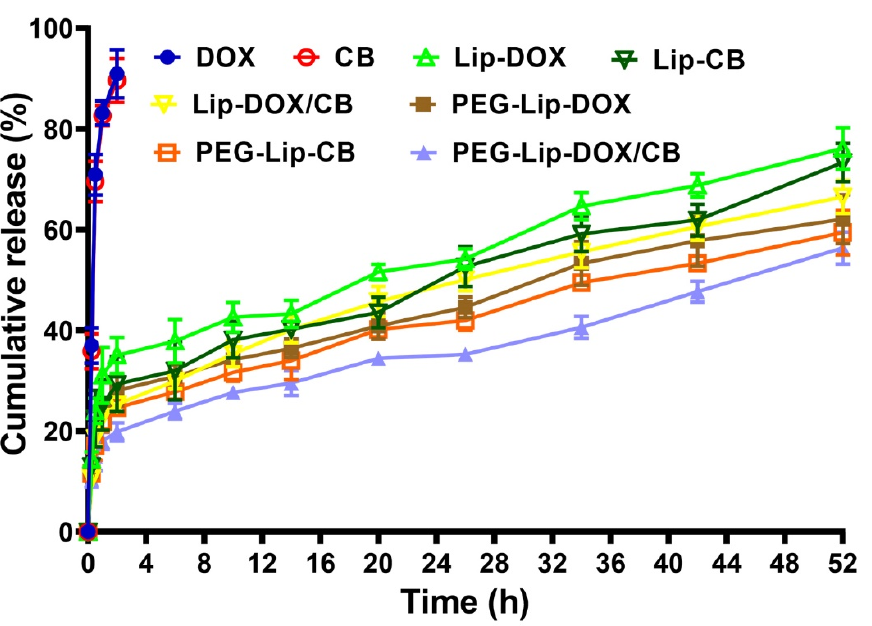
Figure 2. Cumulative drug release from DOX and CB solutions, Lip-DOX, Lip-CB, Lip-DOX/CB, PEG-Lip-DOX, PEG-Lip-CB, and PEG-Lip-DOX/CB. As the figure shows, the amount of drug release from the PEGylated nanoparticles, compared to their non-PEGylated counterparts, was significantly lower ( p < 0.05). Results are expressed as mean ± SD of three independent experiments.